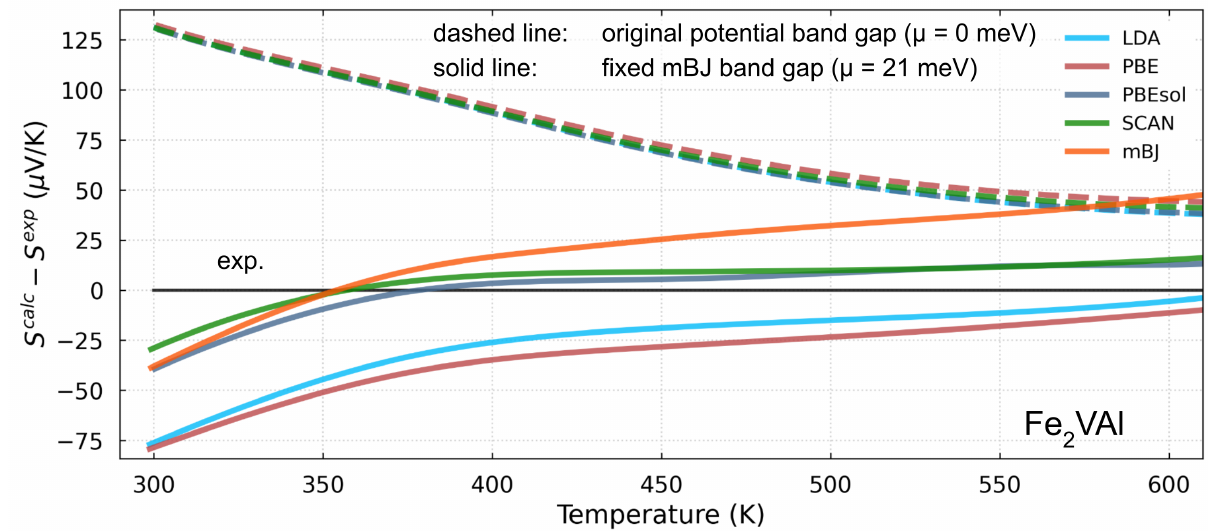
Figure 25. Calculated values of S for Fe 2 VAl as a function of temperature obtained using LDA, PBE, PBEsol, SCAN